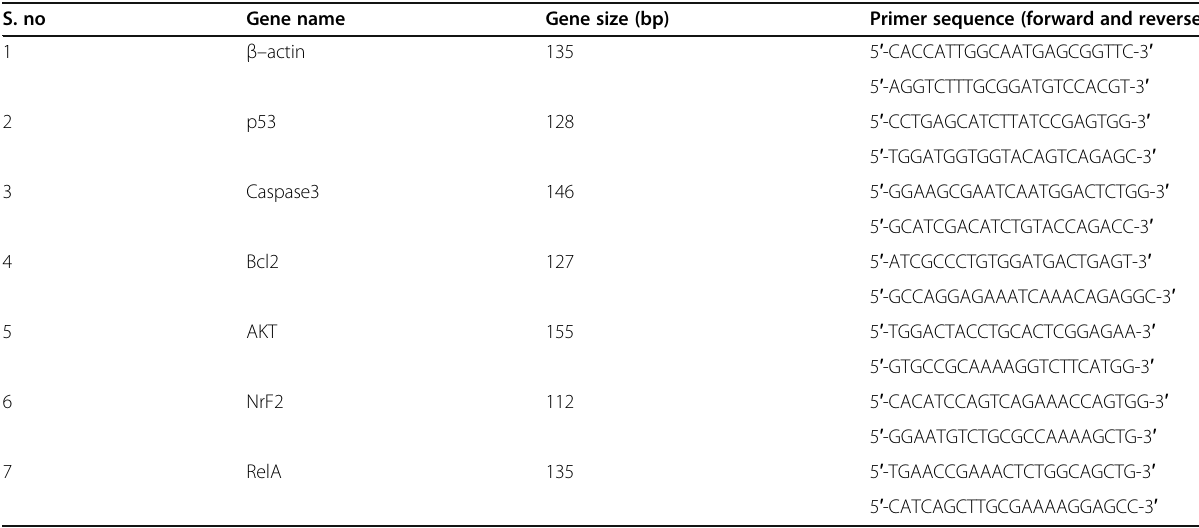
Table 2 Primer sequences of apoptosis-related genes and β – actin as the control